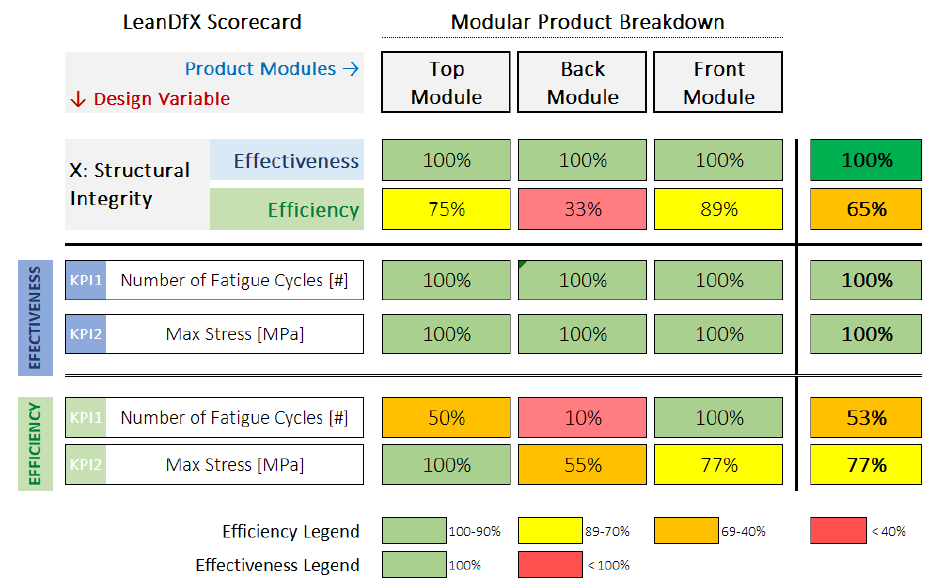
Figure 21. Lean DfX structural integrity domain scorecard for iteration “4” of overall structure and its main modules.